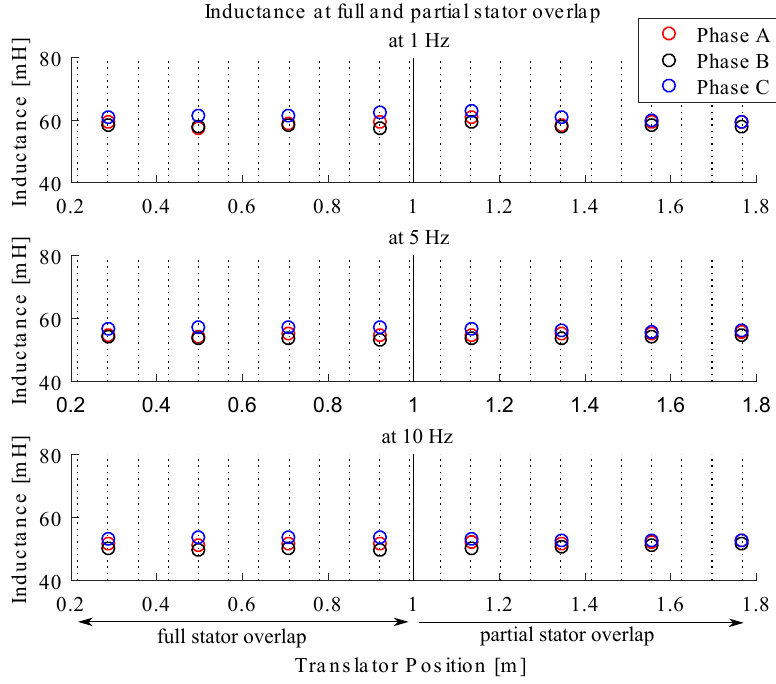
Figure 6. Inductance measurements on the three stator phases of the generator at 1 Hz, 5 Hz and 10 Hz, during full and partial stator